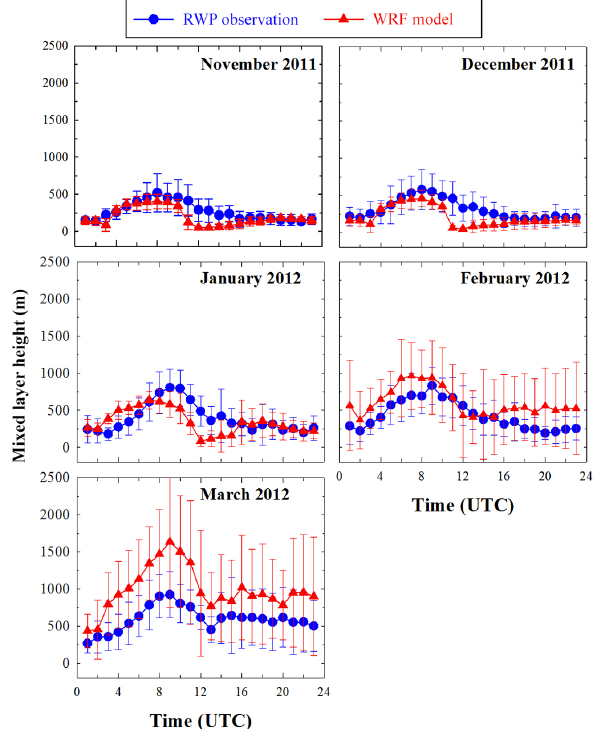
Figure 8. Comparison of the monthly averaged diurnal variations in the boundary layer height determined from RWP measurements and WRF simulations at Nainital during the study period.